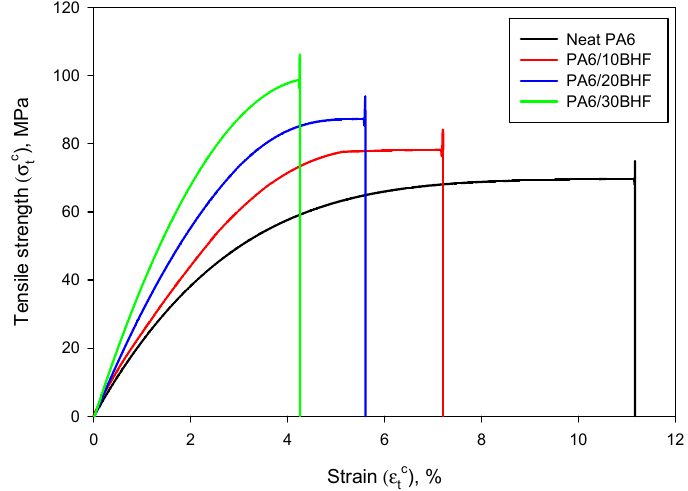
Figure 4. Stress-strain curves of neat PA6 and the BHF-reinforced composites.